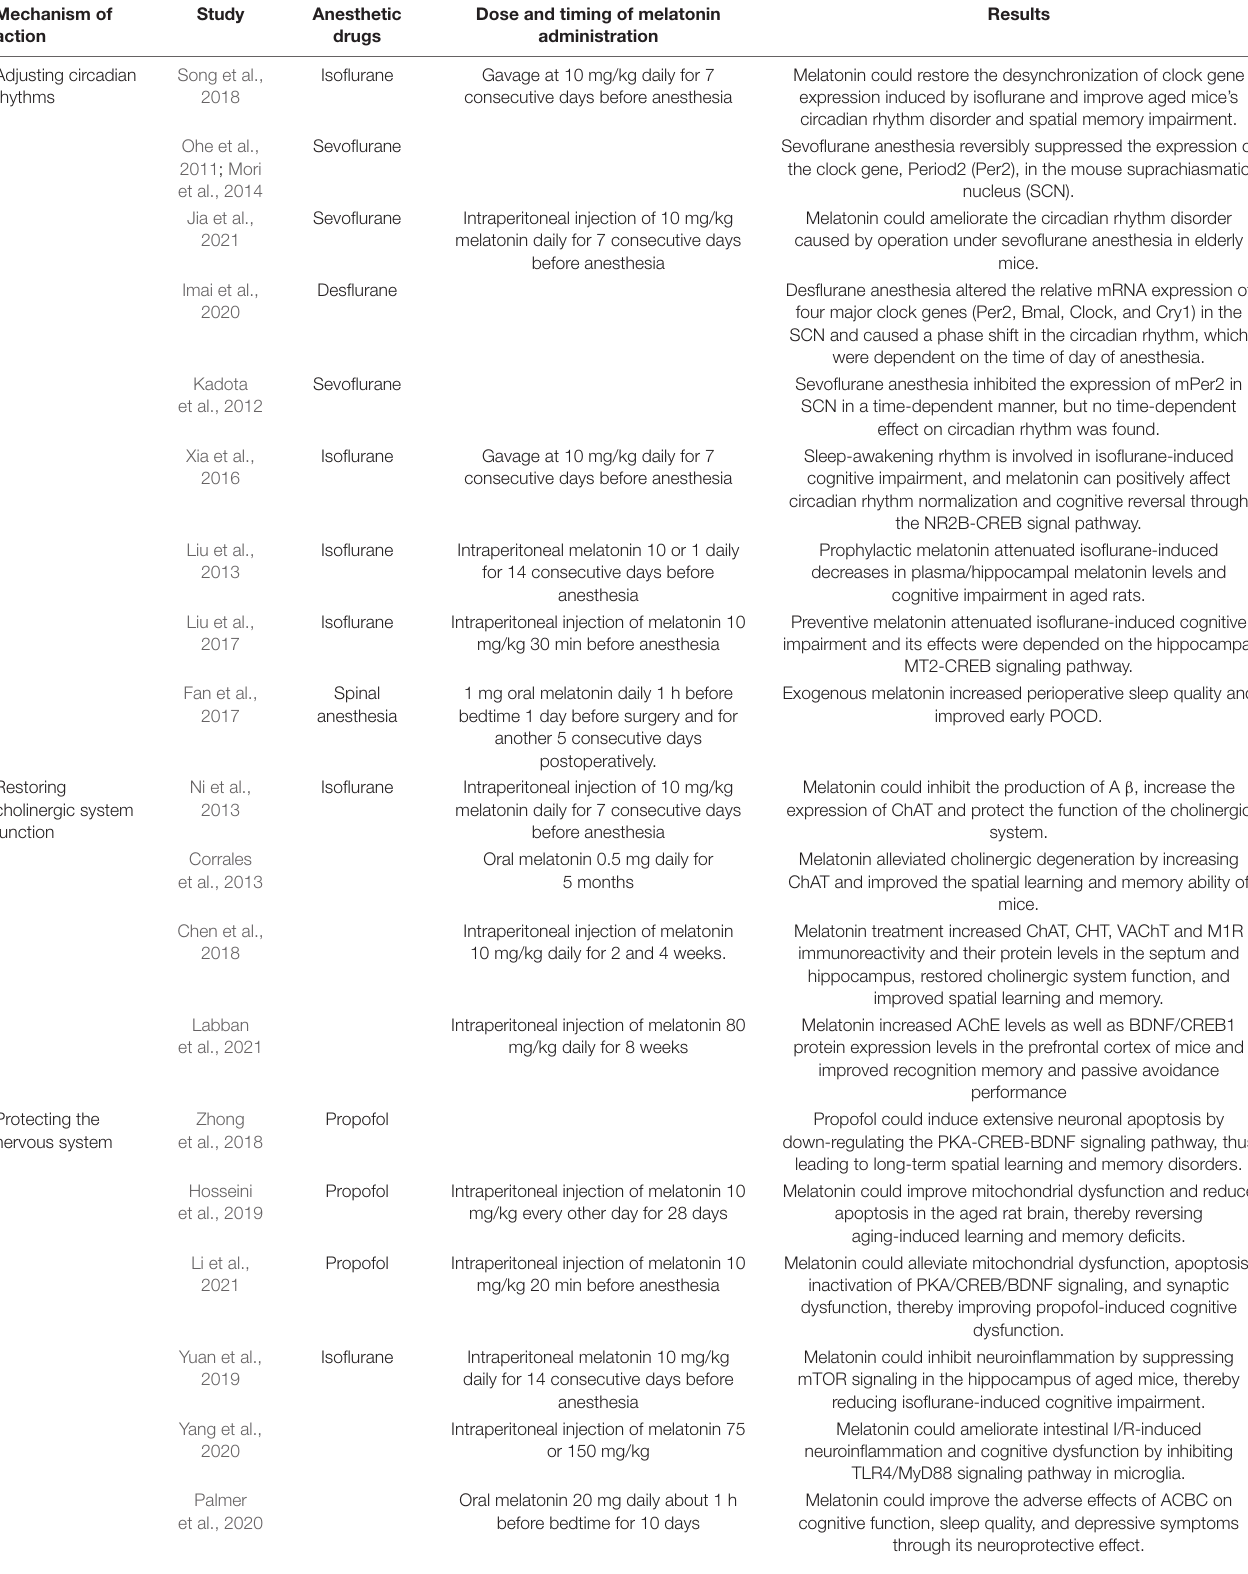
TABLE 1 | Summary of experiments related to melatonin for the prevention and treatment of postoperative cognitive